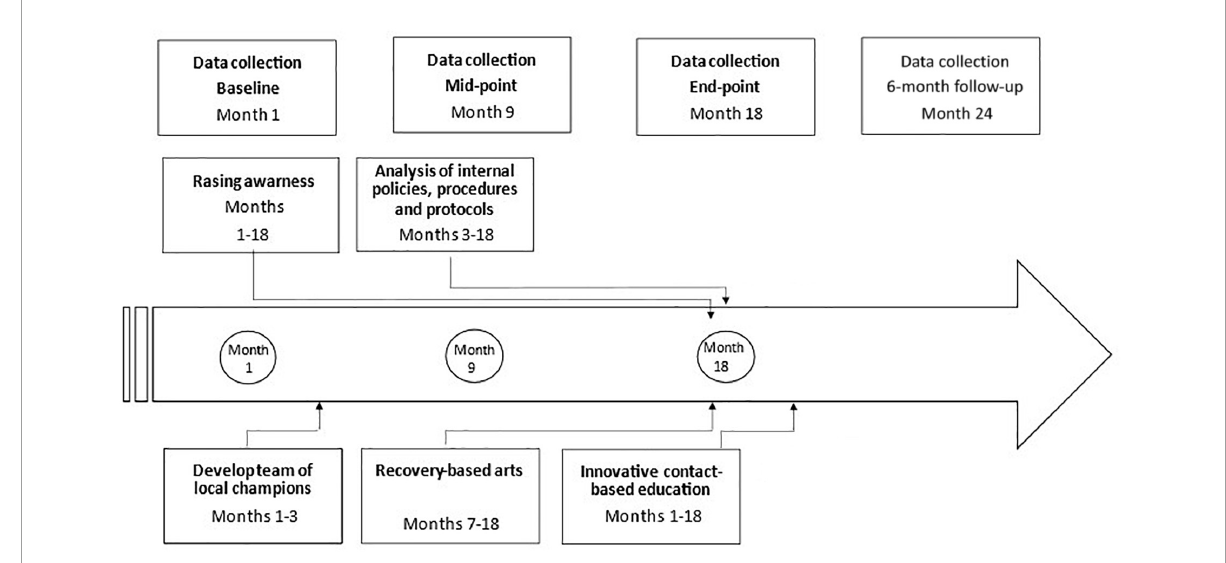
FIGURE4 Intervention implementation